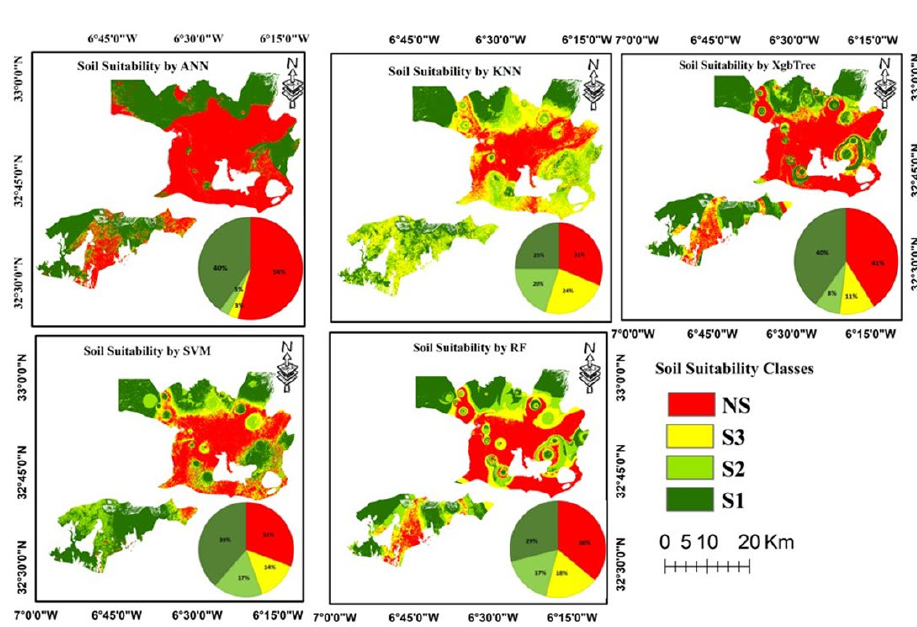
Figure 6. Factors of importance in the five models.